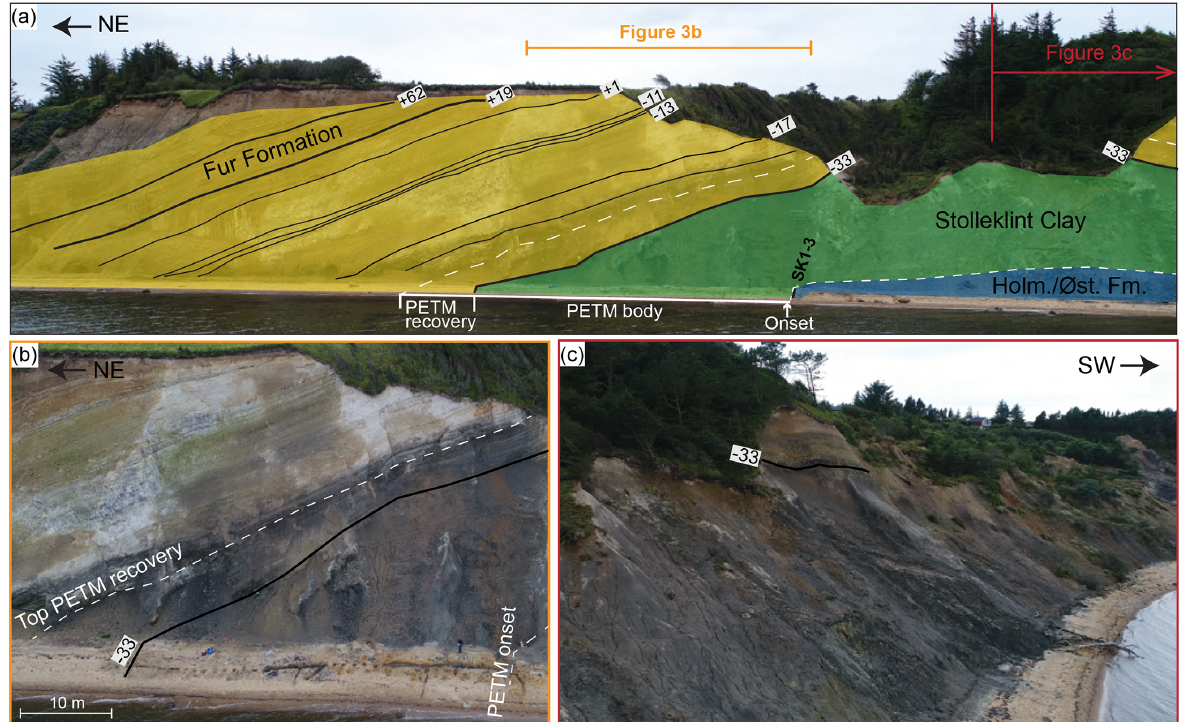
Figure 3. (a) The coastal cliff at the Stolleklint beach with the main stratigraphic units shown as yellow (Fur Formation), green (Stolleklint Clay), and blue (Holmehus/Østerrende Formation). The black lines indicate certain key ash layers, and white dashed lines indicate the upper and lower bounds of the PETM CIE. (b) Close-up of the central part of the cliff face showing the colour difference between the dark PETM clays and the light post-PETM diatomites. Ash − 33 and the PETM CIE are indicated. Note the 43m long ditch on the beach where most of the samples were collected. (c) Picture of the continued cliff side towards the west, showing the extensive coastal erosion. Approximate location of Ash − 33 is